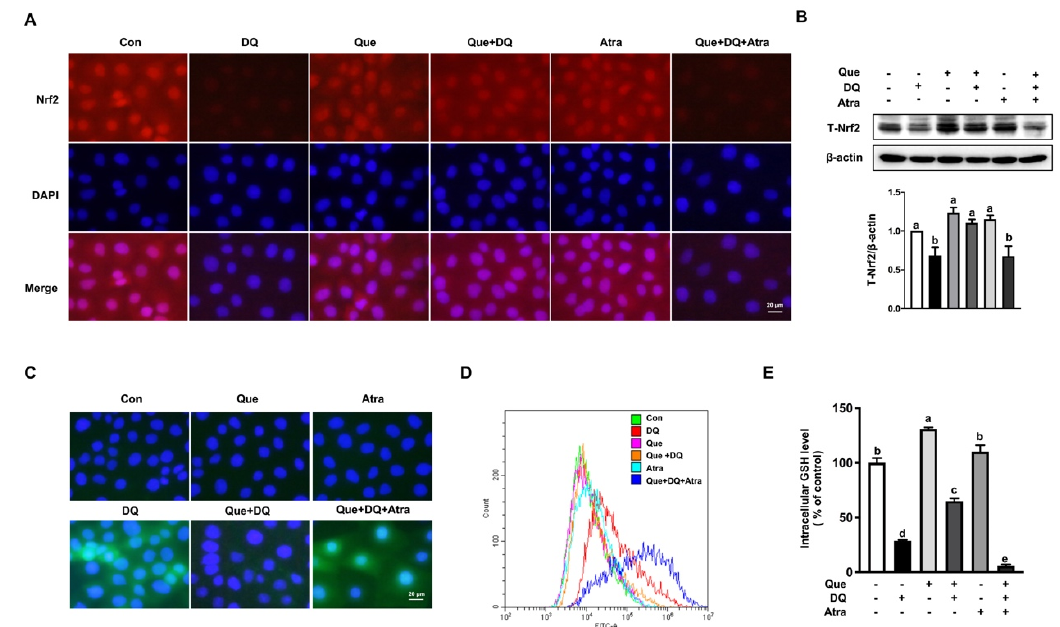
Figure 5. Quercetin protected against diquat-induced ROS production and GSH depletion in a Nrf2-dependent manner. IPEC-1 cells pretreated with or without quercetin (5 µ M, 24 h) were challenged with diquat (100 µ M) for 6 h in the presence or absence or Atra (1 µ M). The distribution of Nrf2 in nucleus ( A ) and the abundance of T-Nrf2 ( B ) were determined. ( C ) Intracellular ROS levels were determined by fluorescence microscope (magnification ×400). ( D ) DCFH-DA-positive populations were detected by flow cytometry analysis. ( E ) Intracellular GSH levels were measured. Representative experimental results were repeated in three independent experiments and values are means ± SEMs, n = 3. Means without a common letter are considered as a significant difference, p < 0.05.